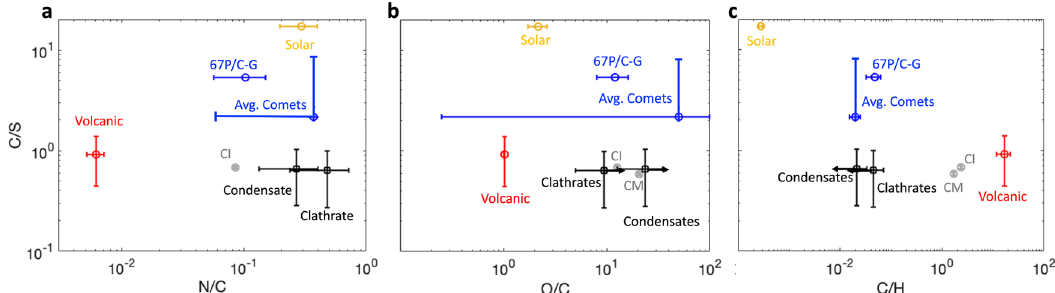
Fig. 1 Elemental composition of the Lunar regolith in the top 1 – 3 m of the Cabeus Crater Permanently Shaded Region sampled by the Lunar CRater Observation and Sensing Satellite compared to the elemental composition of possible sources. The regolith elemental composition (black squares) of ( a ) N/C, ( b ) O/C, and ( c ) C/H compared to C/S is determined based on the assumption that the volatiles are either stored as Clathrates or are condensed onto the regolith as Condensates. All sources are identi fi ed by name in the fi gures next to their symbol. Uncertainties are extrapolated from reported measurements according to standard methods. Note that no single source exactly matches all of the elemental ratios. Data are provided in Supplementary Table